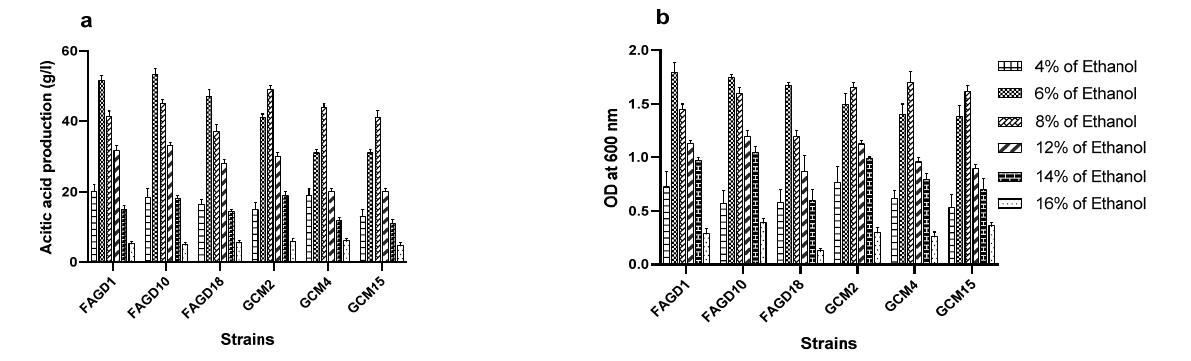
Figure 3. Effect of variation of pH on acidification capacity of six strains.